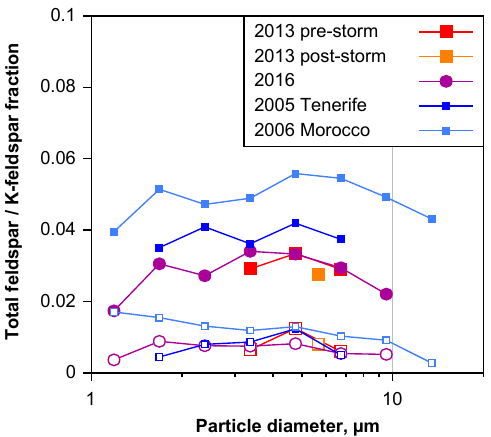
Figure 13. Number ratio of total feldspar (filled symbols) and K- feldspar (open symbols) to total silicate particles, as a function of particle aerodynamic diameter in dry deposition collected on Bar- bados. For comparison, data from Tenerife (Kandler et al., 2007) and Morocco (Kandler et al., 2009) are given. Only data points with less than 30% relative counting error are